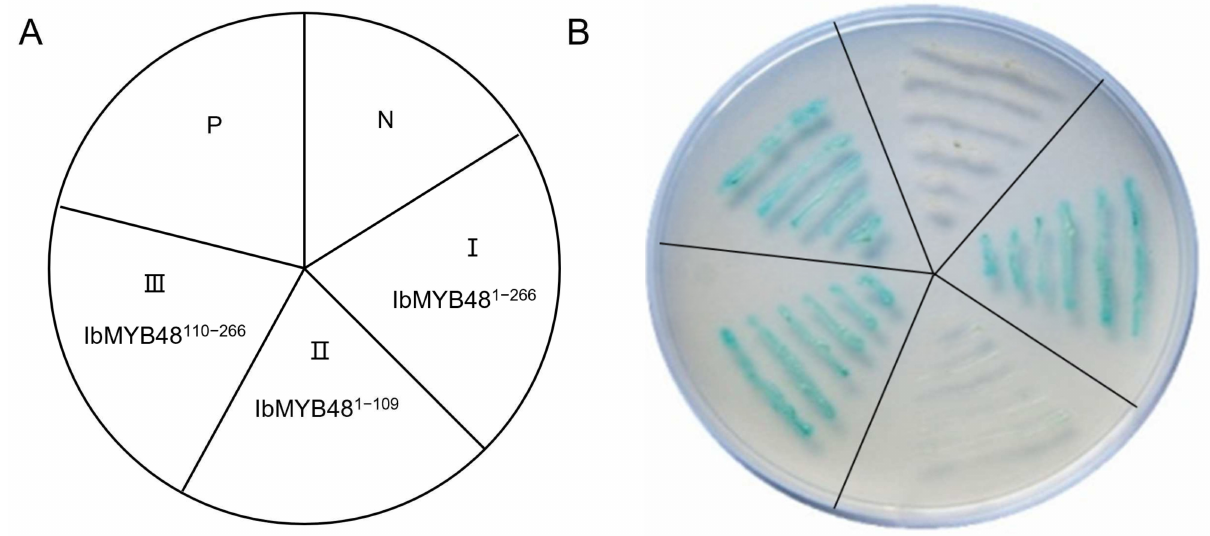
Figure 4. Experiment of IbMYB48 transactivation activity in yeast using full-length as well as truncated forms. ( A ) The pGBKT7-53 (P) and pGBKT7-Lam (N) were used as positive and negative control, respectively. Part I, Part II, and Part III represents the pGBKT7-IbMYB48 1 − 266 , pGBKT7- IbMYB48 1 − 109 and pGBKT7-IbMYB48 110 − 266 were transformed into Y2HGold, individually. ( B )